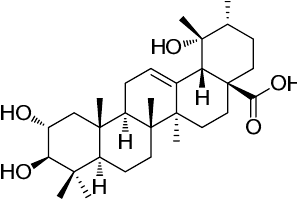
Figure 1. Structure of tormentic acid.